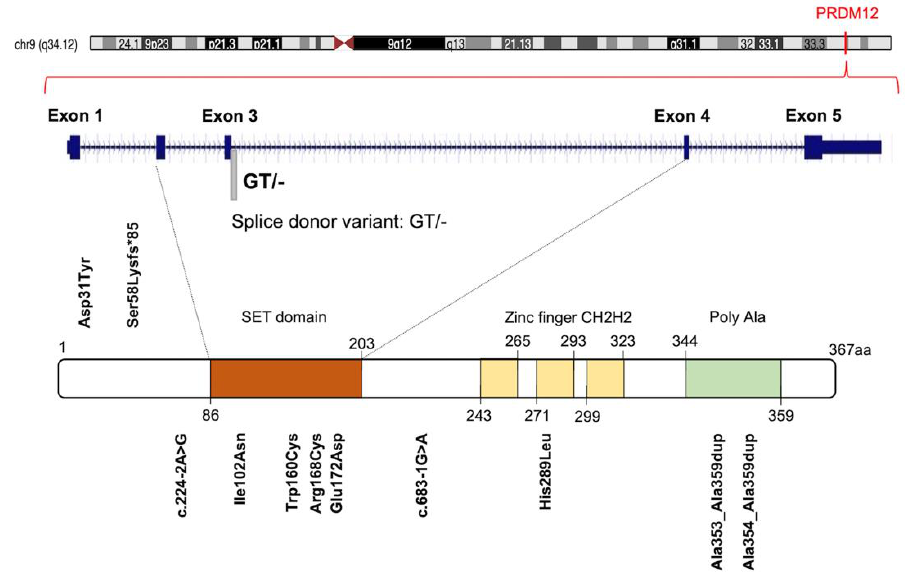
Figure 1. Graphic illustration of human PRDM12 gene, protein and distribution of known congenital insensitivity to pain (CIP)-causing mutations. Figure shows a schematic representation of PRDM12 architecture: Su(var)3-9, Enhancer-of- zeste and Trithorax (SET) domain, three ‘classical’ zinc fingers (ZnF_C2H2), and a Poly Ala region. Amino acid numbering is reported. See text for